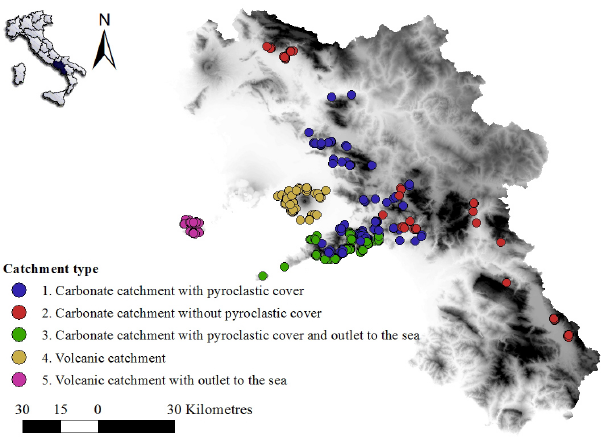
Figure 9. Geographical representation of the events, according to the catchment